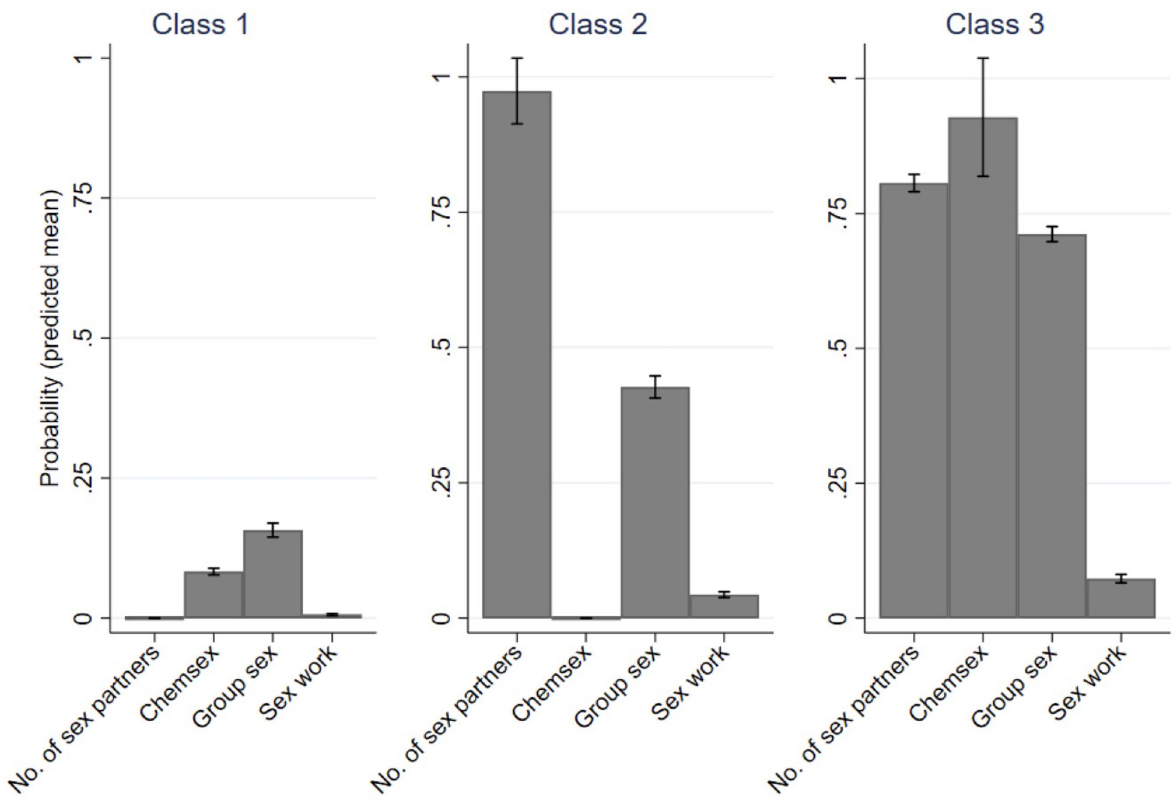
Fig 1. Sexual behavior associated with increased STI risk across three latent classes. Explanation of data: Bars represent the mean proportion of visits reporting each sexual behavior respectively for class 1, 2 and 3. All sexual behaviors refer to the six months prior to the visit. Number (= No.) of sexual partners refers to those with � 6 sexual partners in the six months prior to the visit. Chemsex was defined as using cocaine, ketamine, mephedrone, gamma-hydroxybutyrate (GHB), gamma-butyrolactone (GBL), and/or crystal meth around or during sex. Bands at the top of each bar represent 95% confidence intervals, which were calculated using the delta method.